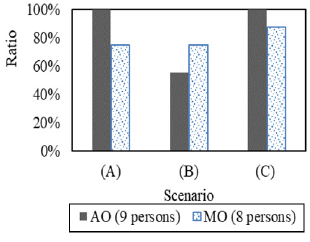
Figure 8 Proportion that proceeded to the instructed direction